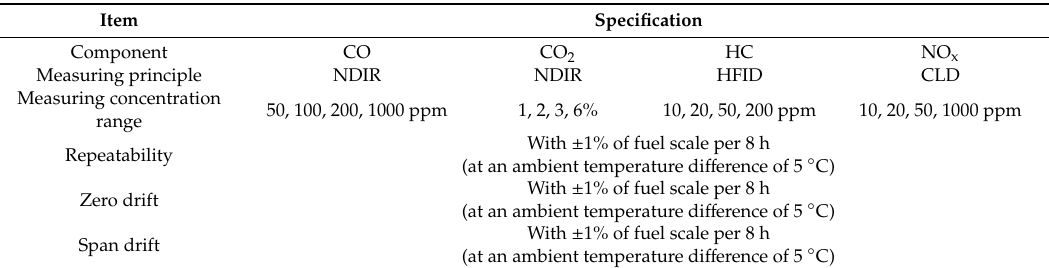
Table 5. Specifications of the test gas